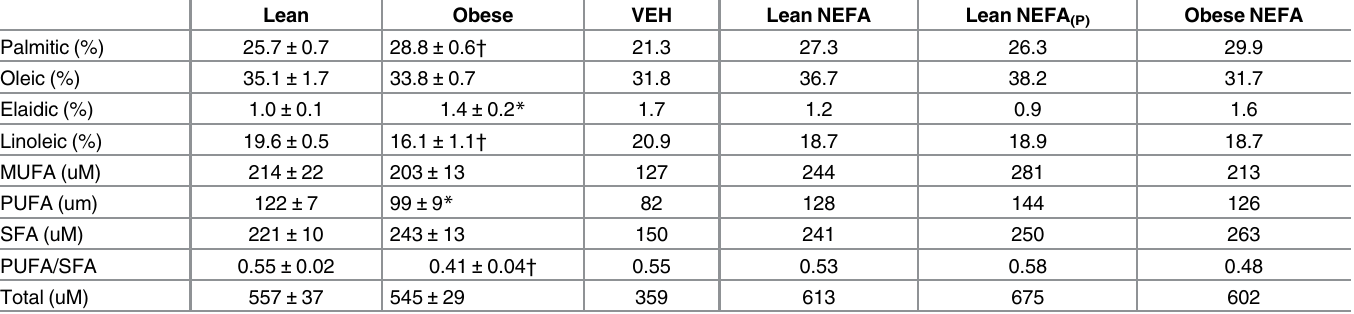
Data are means ± SE for the Lean and Obese * P < 0.05